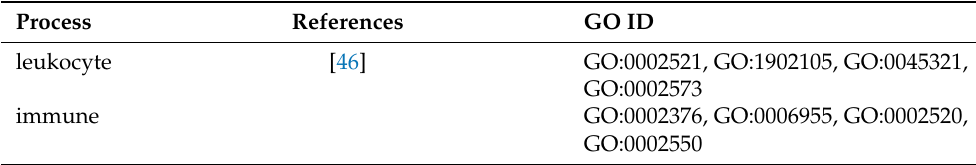
Table 5. GO terms of the biological processes selected by Method 2. We note that the terms differentiation, immune, and leukocyte are the most significant as far as number of associated GO labels. Moreover, also the other terms comprised in the selection appear to be strictly correlated to CML. In this case, the correlation is clearly higher than the one returned by Method 1. This is due to the fact that the key terms comprised in the selection refer to more specific biological processes involved in